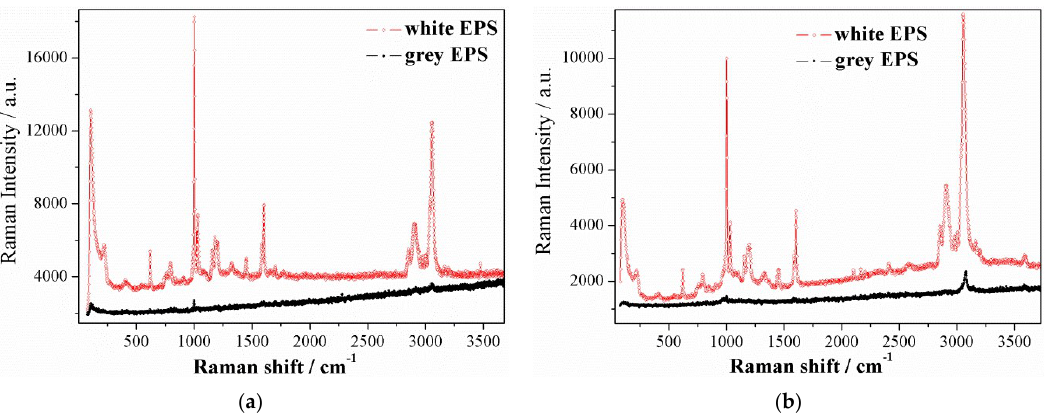
Figure 6. ( a ) Raman spectra for selected “white” part of the EPS B (red line) and for the “grey” EPS C (black line) products. The 633 nm He–Ne-ion laser line was used as the excitation wavelength. ( b ) Raman spectra for selected “white” part of the EPS B (red line) and for the “grey” EPS C (black line) products. The 514 nm Ar-ion laser line was used as the excitation wavelength.